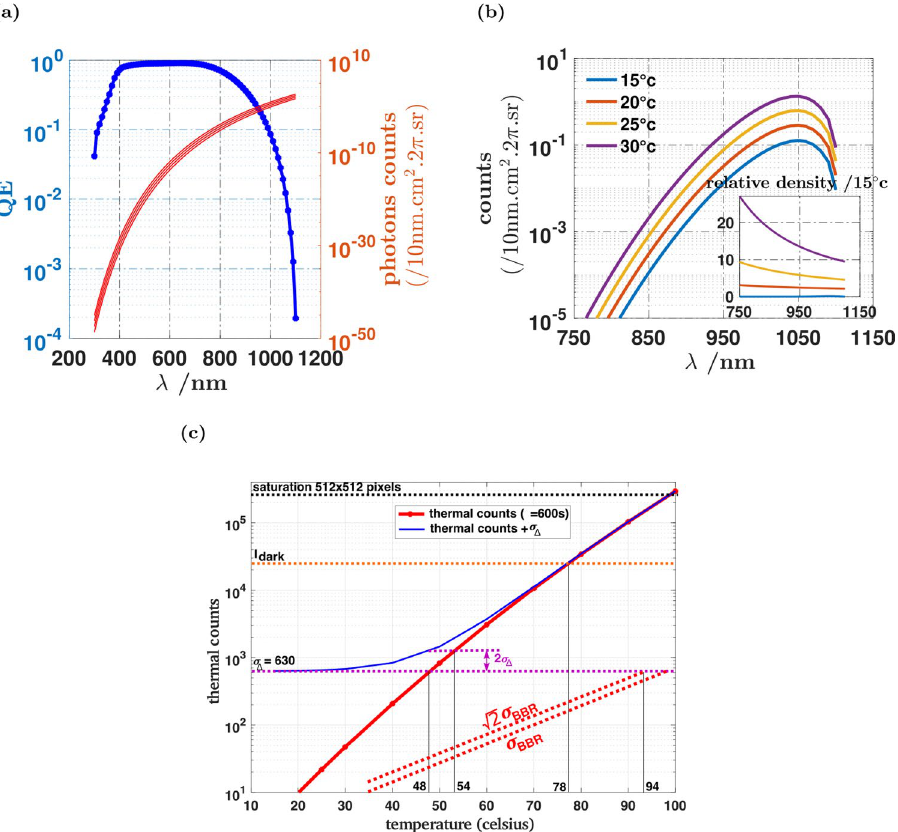
Figure 5. Sensitivity to thermal radiation and radiation temperature. ( a ) Shows the quantum efficiency QE ( (cid:31) ) of the detector (blue line), and the blackbody radiation spectrum (red lines), taken as the photonic spectral irradiance P ( T , (cid:31) ) in units of number of photons per 10 nm units in the spectrum, for 4 different temperatures (15, 20, 25 and 30 °C). The spectral irradiance varies by more than 50 decades over the spectral window of the camera. The effect of temperature on the detector is computed from the effective irradiance spectrum obtained as the product QE ( (cid:31) ) P ( T , (cid:31) ) of the spectral irradiance multiplied and the quantum efficiency. ( b ) Shows the effective thermal irradiance spectra for different temperatures, and the insert shows these spectra normalized by the 15 °C spectrum. The effective irradiance spectra of ( b ) are then integrated over the relevant part of the spectrum, over 2 π steradian, and over the detector area and for τ = 600 s to obtain the total thermal count 630 obtained from Fig. 4a, to the dark shown on ( c ) (red line). This count is compared to the noise floor σ � = contribution, and to the binary saturation count 512 2 . The standard deviation of thermal counts is also shown (dotted red